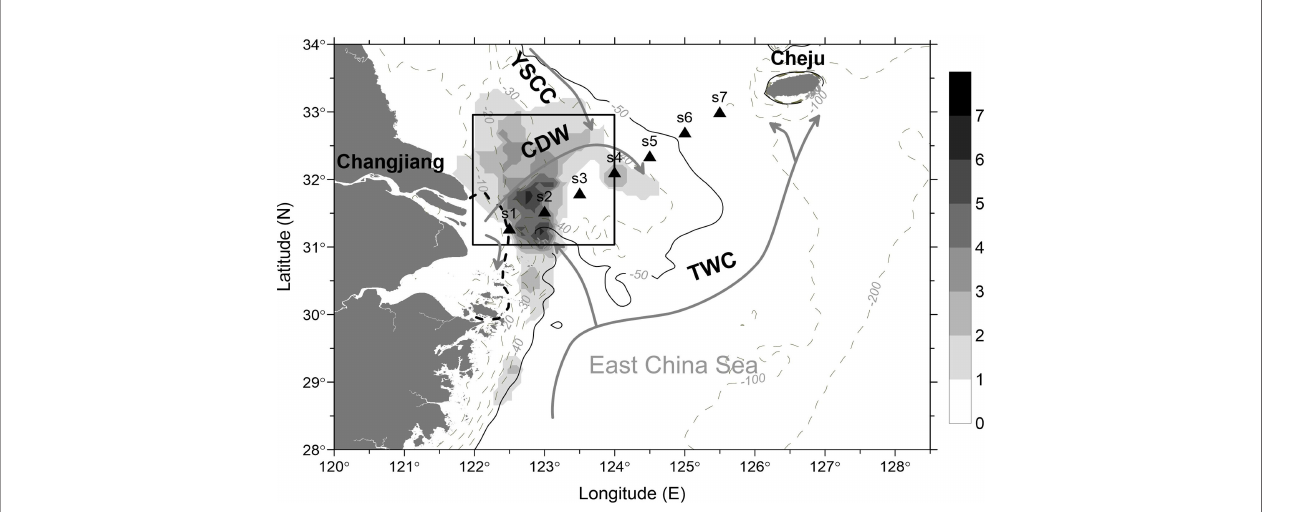
FIGURE 1 | Topography (thin contour), reported hypoxia areas (1998 – 2015; shading, see details in Table S1 ), and schematic of the summer circulation (thick solid lines) off the Changjiang Estuary. The black triangles indicate sampling stations along Section C-C during 1997 – 2014. The dashed black curve indicates the surface suspended sediment front near the Changjiang River mouth (redrawn according to Li et al., 2021). The solid black box indicates the area used for the domain average for the climatic and hydrographic factors listed in Table 2 . The arrows indicate the CDW, Changjiang Diluted Water; YSCC, Yellow Sea Coastal Current; TWC, Taiwan Warm